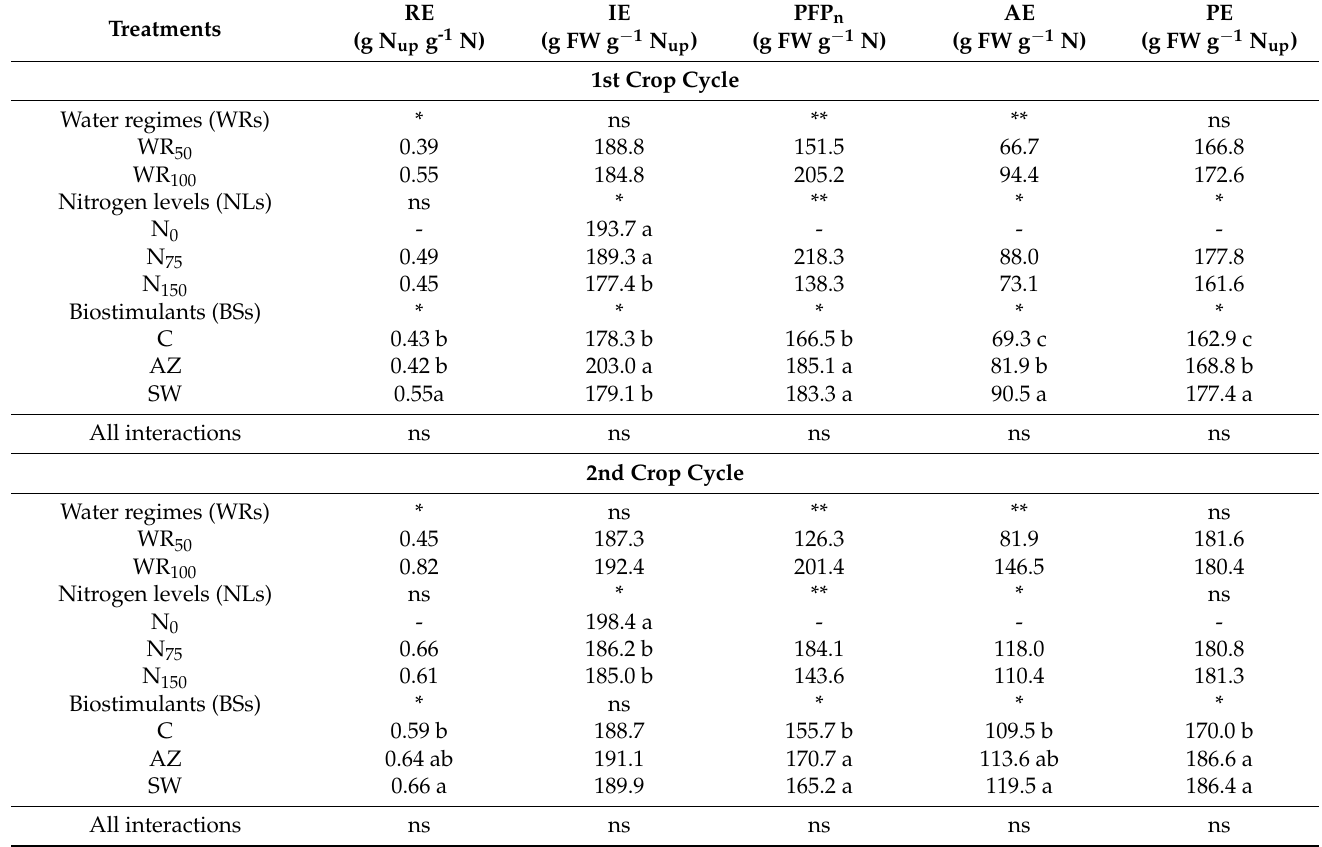
Table 3. Effect of water regimes, N levels, and biostimulants on some indicators of the N use efficiency (NUE) of wild rocket for the two crop cycles: apparent recovery efficiency (RE), internal